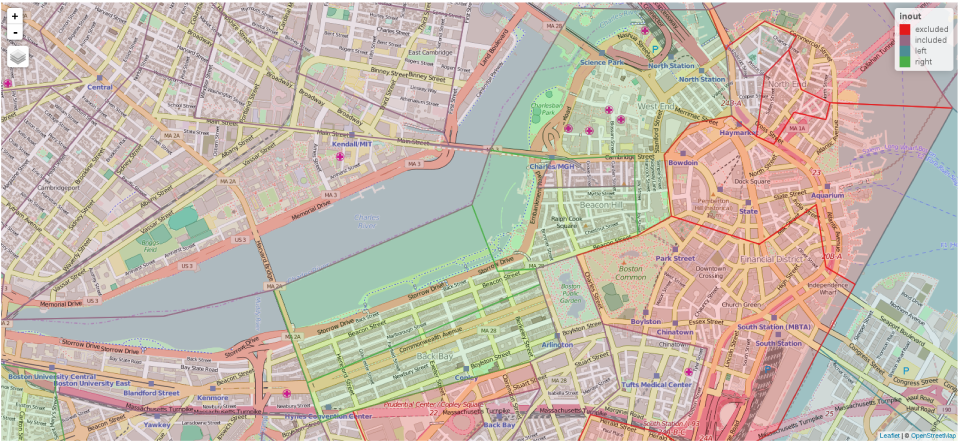
Figure A.2: A screen-dump of central Boston composed using the R interactive mapping function mapview shown on an OpenStreetMap basemap; red-shaded tracts are excluded from the 506 tract dataset, purple tracts are included, blue tracts are left-censored ( < $5,000), and green tracts are right-censored ( > $50,000).